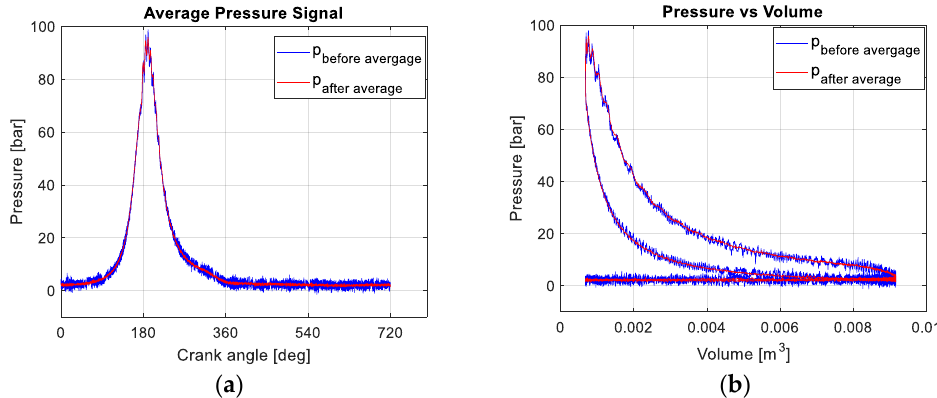
Figure 7. In-cylinder pressure before and after cyclic average: ( a ) p - φ diagram; (b ) p - V diagram.